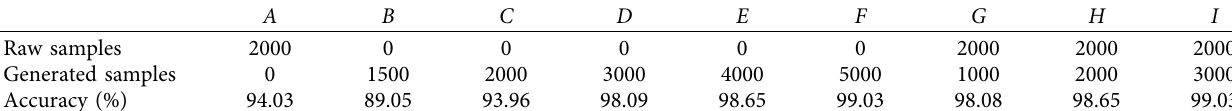
Figure 12: Comparison of dimensionality reduction visualization results on Dataset C. (a) GAN-SAE. (b) WGAN-SAE. (c) WGAN-GP- SAE. Table 3: Different training data settings using real samples and generated samples and the classification results.